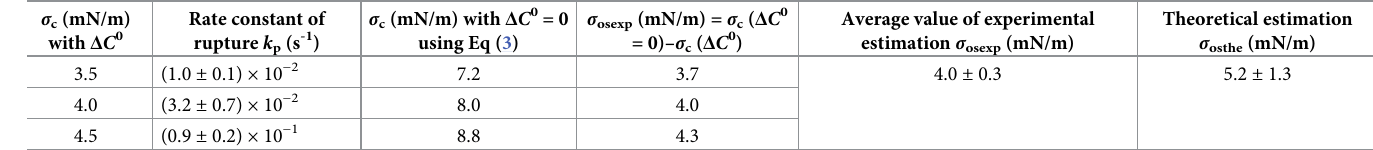
Table 2. An estimation of membrane tension of DOPG/DOPC/chol (46/39/15)-GUVs for Δ C 0 = 19 mOsm/L and C out = 369 mOsm/L. Rate constant of σ c (mN/m) with Δ C 0 rupture k p (s -1 )